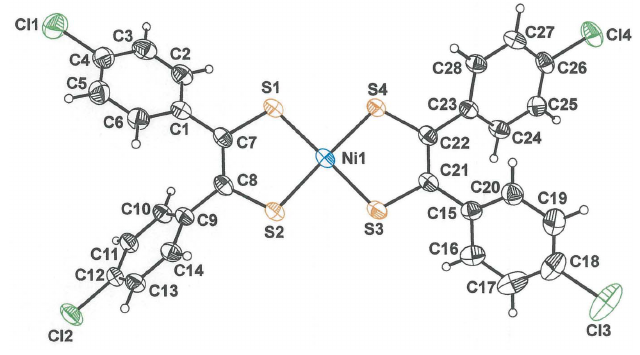
Figure 2 Displacement ellipsoid plot (50% probability level) for bis[1,2-bis(4- chlorophenyl)ethylene-1,2-dithiolato(1 (cid:5) )]nickel(II) with complete atom labeling.